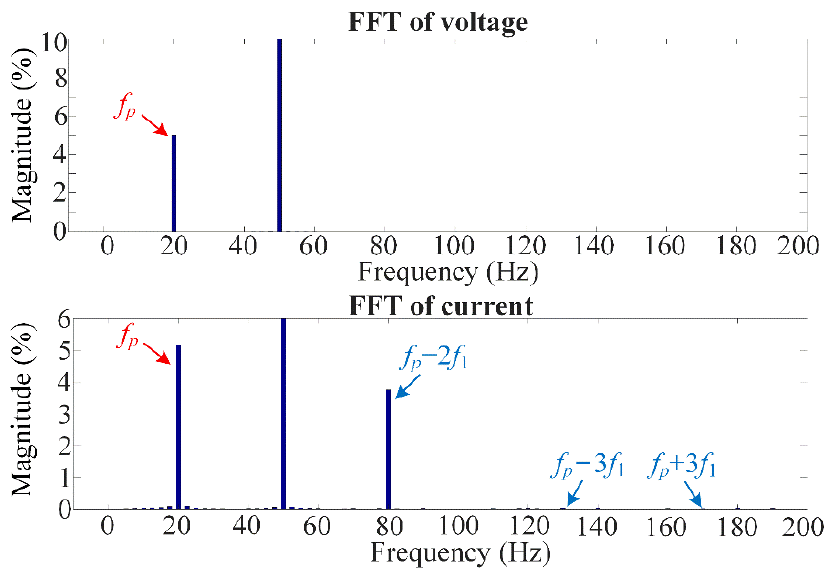
Figure 5. Frequency spectrum of the voltage and current with an injected perturbation voltage at 20 Hz.